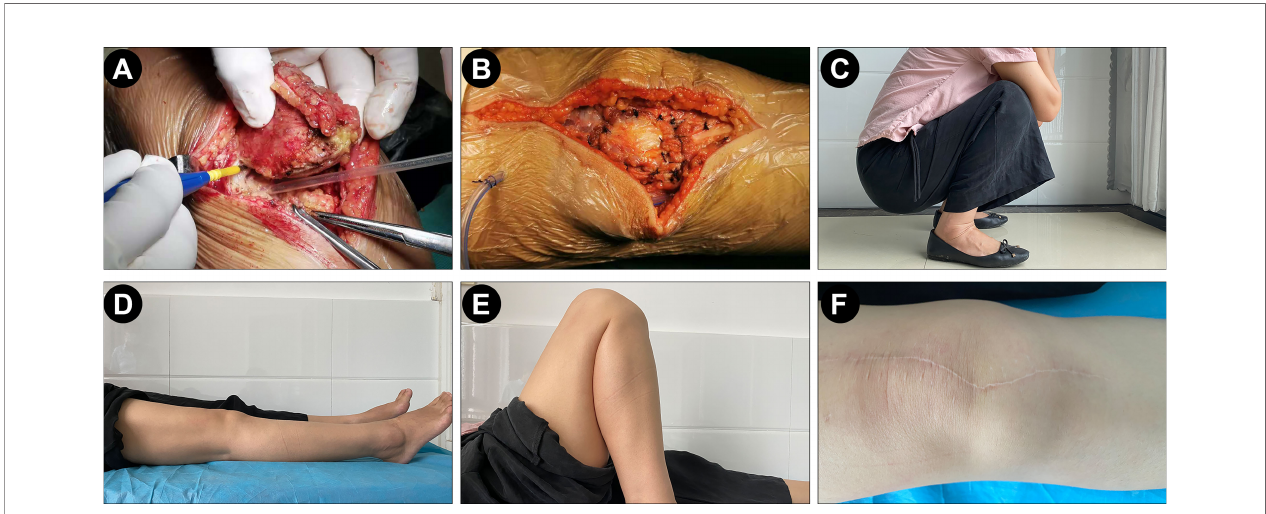
FIGURE 3 | Surgical operation and post-operation follow-up. (A, B) The expansion of quadriceps femoris muscle and the residual support structure surrounding the patella was directly sutured after the patella was completely resected. (C – F) Postoperative functional examination demonstrated a satisfactory functional recovery of the patient.